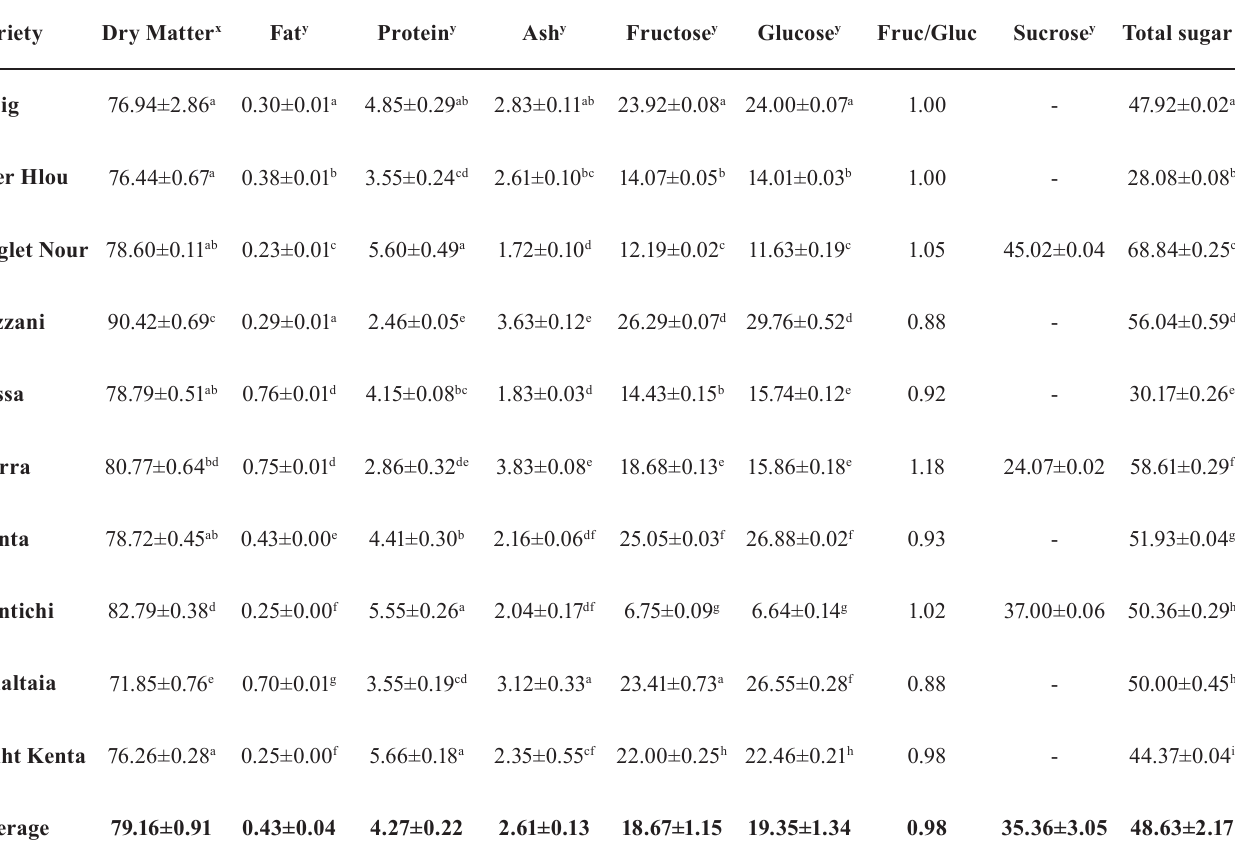
TABLE II - Compositional characteristics of date palm fruit from ten varieties at the Tamr stage Variety Dry Matter x Fat y Protein y Ash y Fructose y Glucose y Fruc/Gluc Sucrose